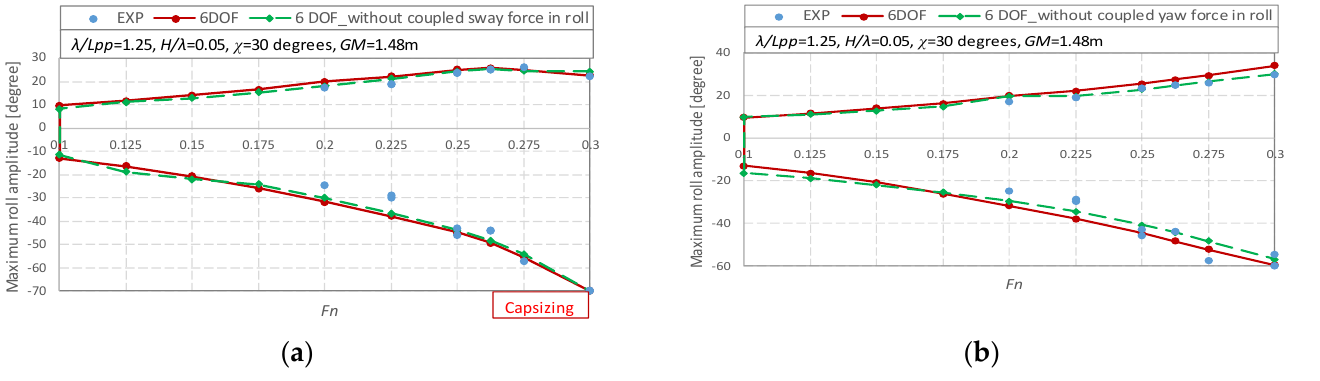
Figure 10. Comparison of the roll angles between the numerical results and test results with the 6